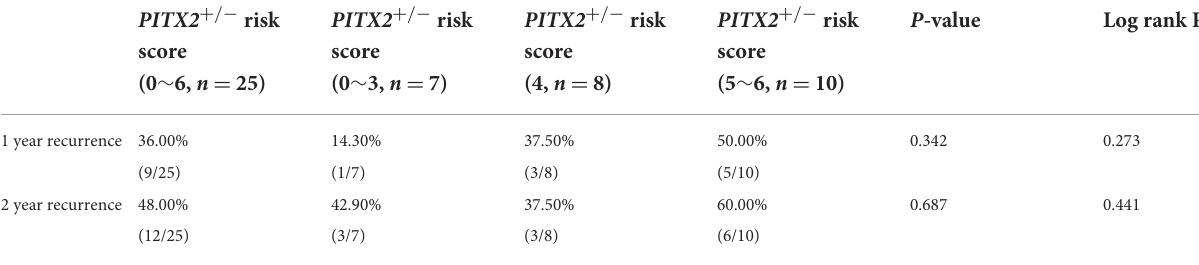
TABLE 3 Clinical AF recurrence based on the PITX2 + / − risk